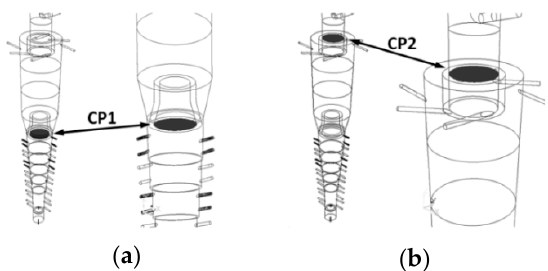
Figure 3. Location of the control planes CP1 and CP2 at the outlet from the chambers PC1 ( a ) and PC2 ( b ).